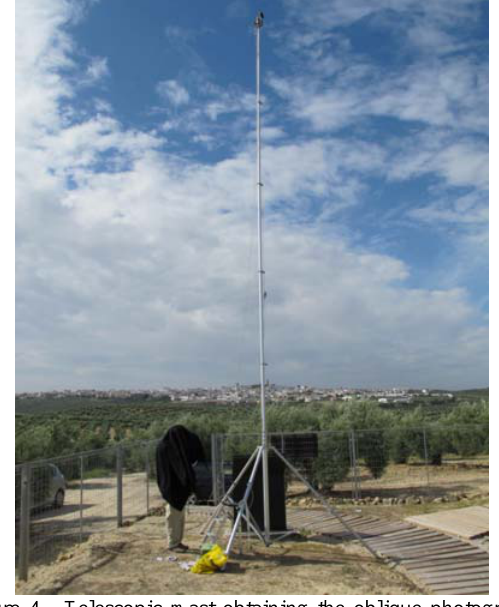
Figure 4. Telescopic mast obtaining the oblique photographs (CP case).